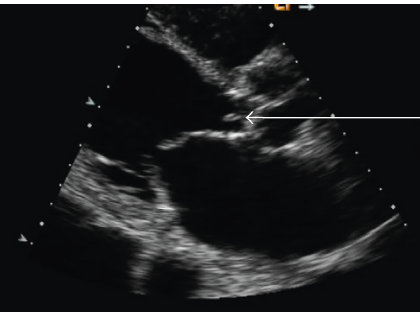
Figure 1: Transthoracic echocardiogram showing vegetation at the valley of the aortic valve cusp.